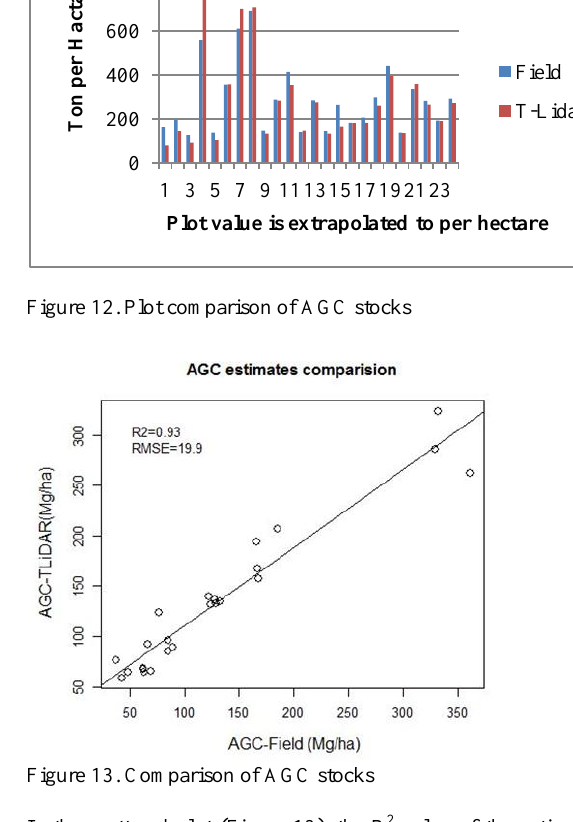
Figure 14. Examples of occlusions: In left photograph, some outer part of the tree bole (black area) is not properly